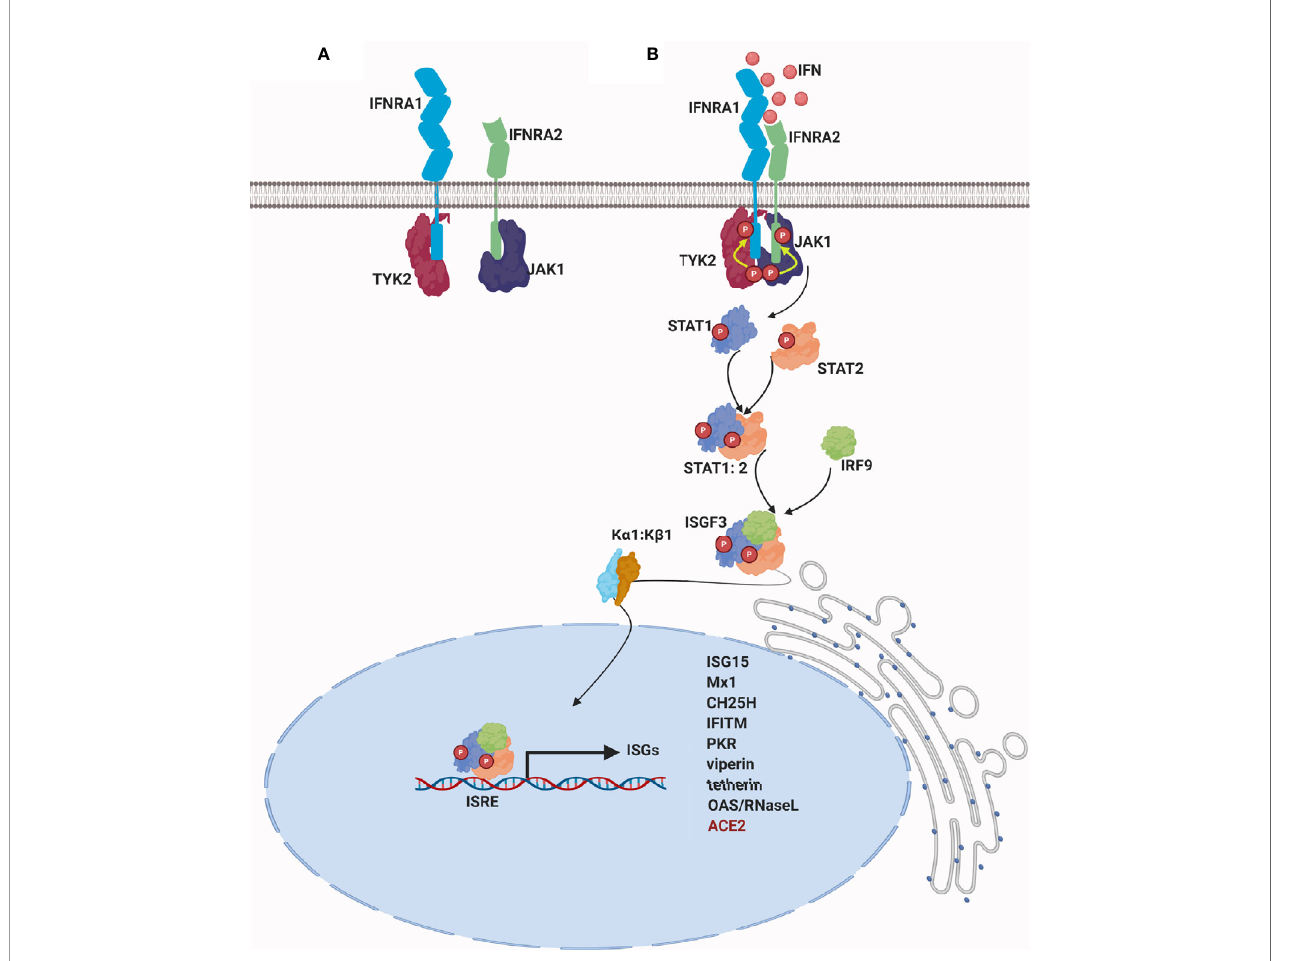
FIGURE 2 | Signaling of type I IFN: (A) In the absence of a stimulus, a speci fi c JAK protein in an inactive conformation binds constitutively to the cytoplasmic domain of each IFN receptor chain: IFNAR1 associates with tyrosine kinase 2 (Tyk2) and IFNAR2 associates with tyrosine kinase Janus 1(JAK1) (36). (B) Upon IFN binding, receptor chains are brought into close proximity, and the two JAK kinase domains remain juxtaposed and undergo transphosphorylation and sustained activation. Once activated, JAKs phosphorylate IFN receptor´s chains on highly conserved tyrosine residues, which lead to the repositioning or binding of STAT proteins (37). As a result, STATs are phosphorylated on conserved tyrosine residues and they are dissociated from the receptor (21). Structural changes of activated STATs leads to heterodimerization of STAT1 and STAT2 and to its interaction with IFN regulatory factor 9 (IRF9). Binding of STAT1, STAT2, and IRF9 results in the formation of a complex called IFN-stimulated gene factor 3 (ISGF3) (38 – 40). ISGF3 complex is normally translocated into the nucleus by binding to karyopherin alpha 1 (KPNA1) and recruits karyopherin beta 1(KPNB1) (41). ISGF3 binds IFN-stimulated regulatory elements (ISREs) in the DNA upstream of IFN-stimulated genes (ISGs), resulting in the transcription of hundreds of type I ISGs. For further details visit (10, 11, 19, 21,